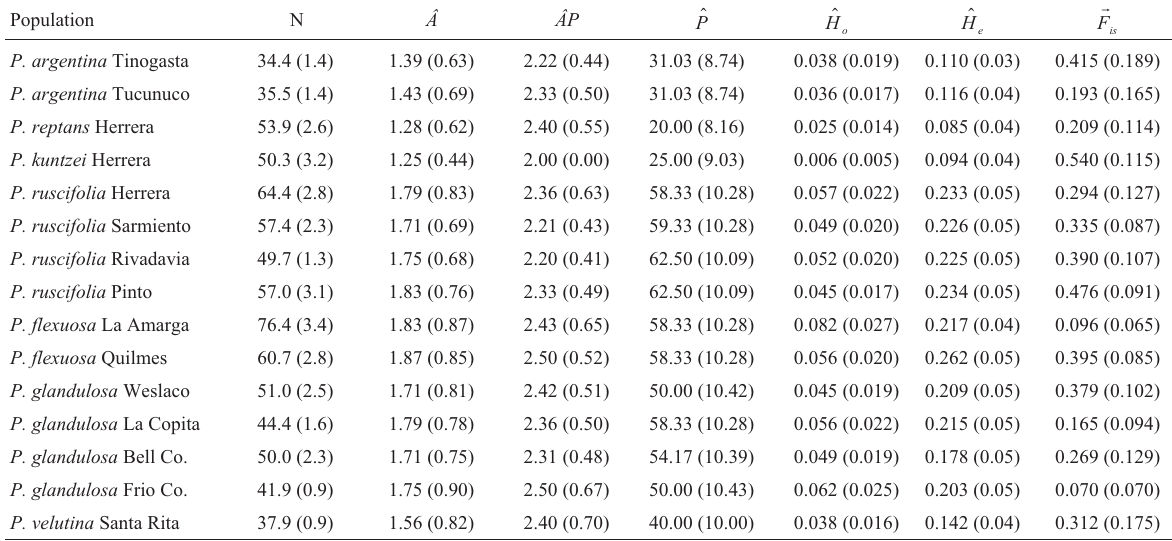
Table 3 - Genetic variability and fixation index ( F IS ) coefficients estimated for each population. N = mean sample size per locus, Â = mean number of alleles per locus, ÂP = mean number of alleles per polymorphic locus, $ = unbiased heterozygosity expected under Hardy-Weinberg. Numbers in parenthesis indicate the standard error. H e Population N Â